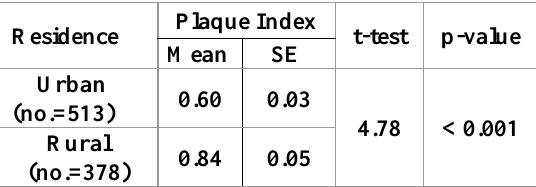
Table 3: Plaque Index (Mean and Standard Error) by residence.